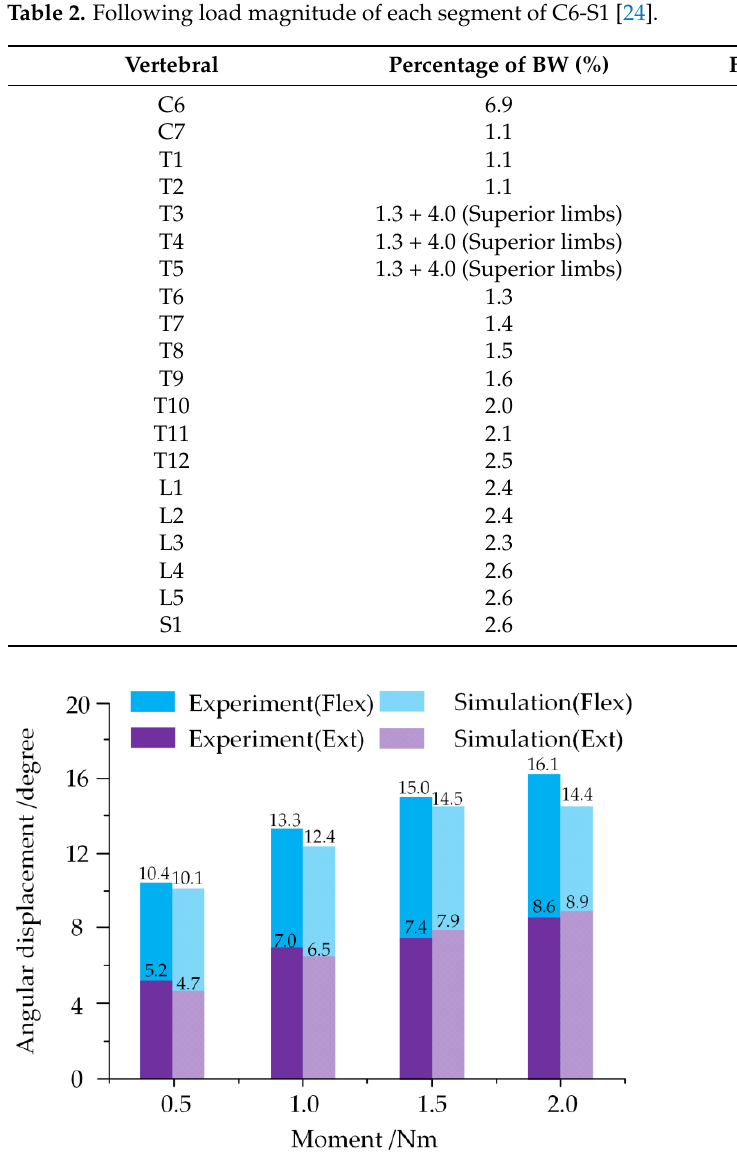
Table 2. Following load magnitude of each segment of C6-S1 [24].